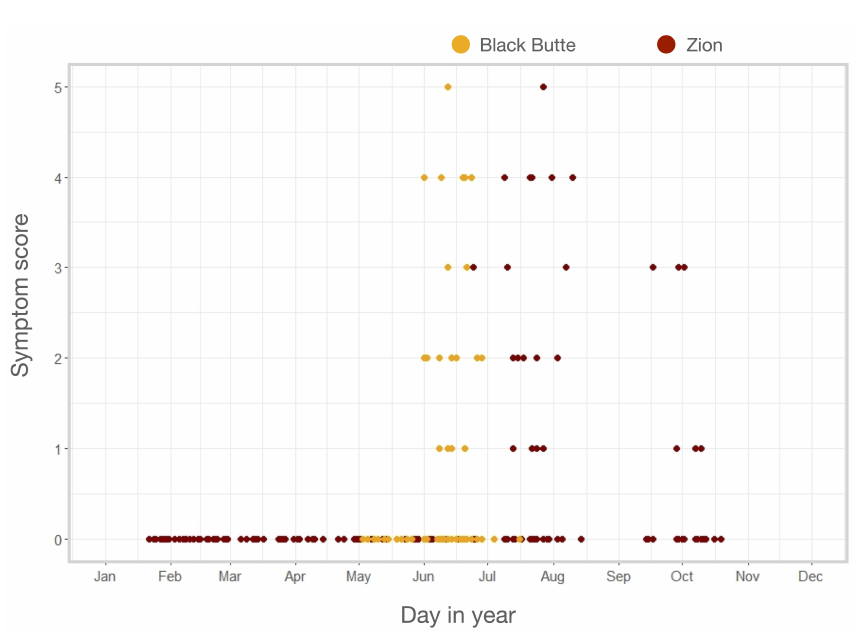
Figure A1. Symptom emergence among lambs in the Zion bighorn population (red) and the Black Butte population (orange), aligned by Julian date.